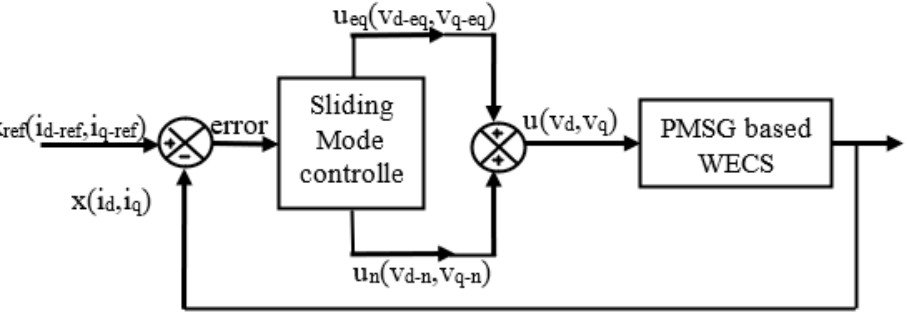
Figure 4. SMC controller